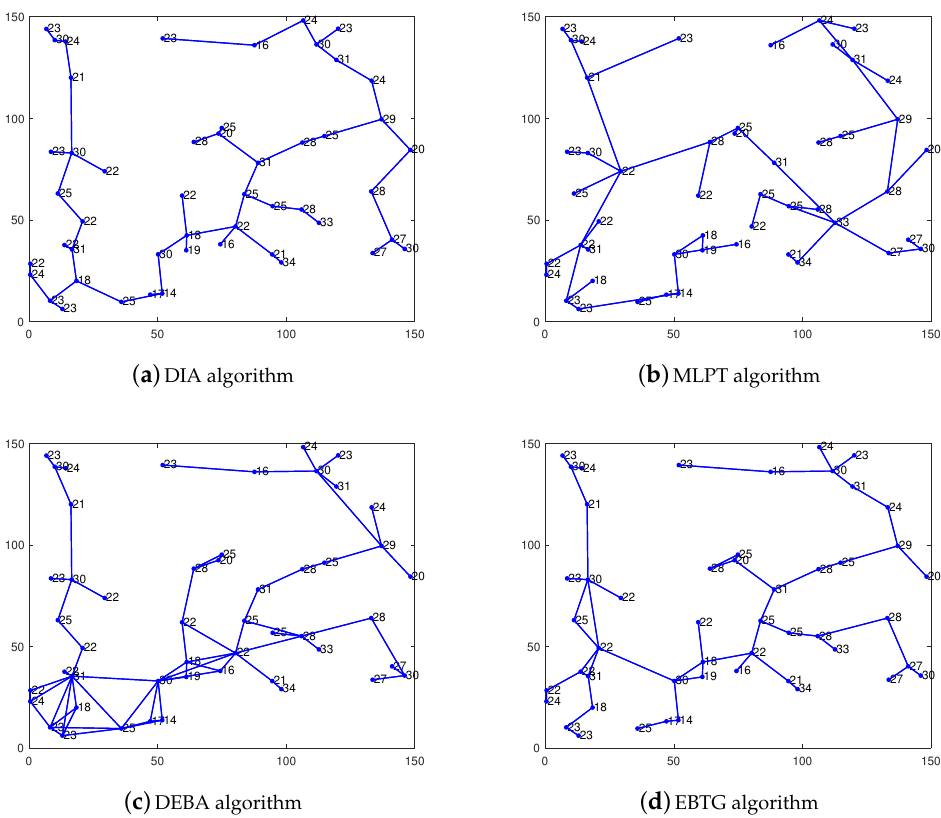
( d ) EBTG algorithm